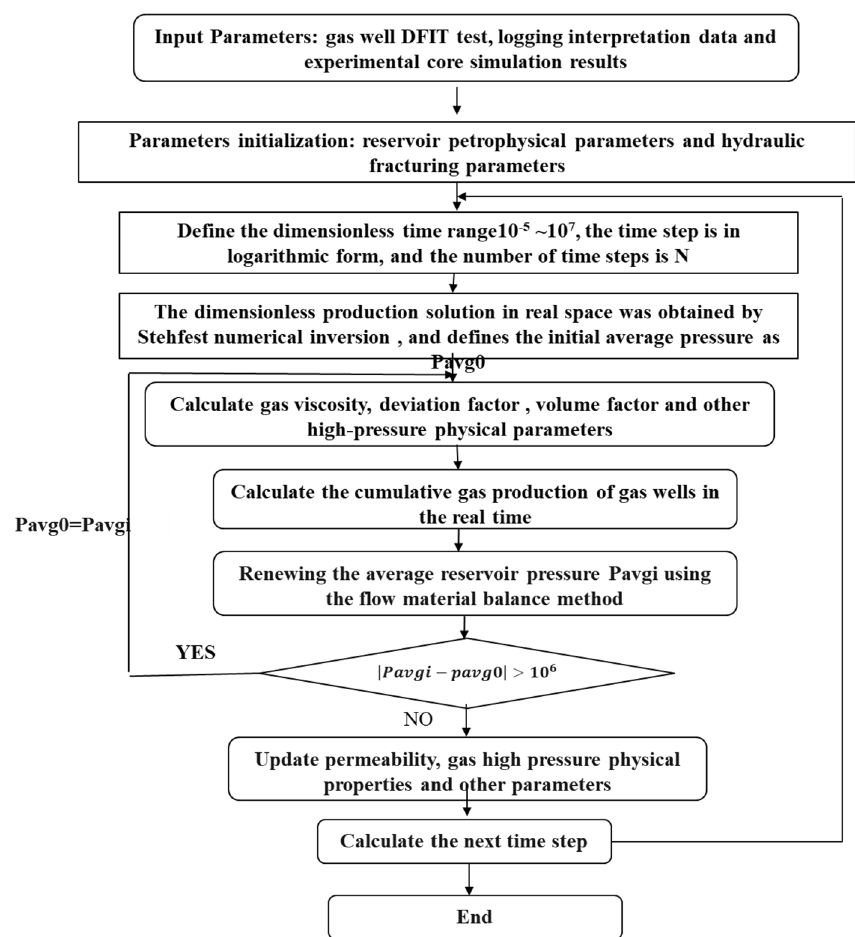
Figure 9. Flow chart of solving pressure control production